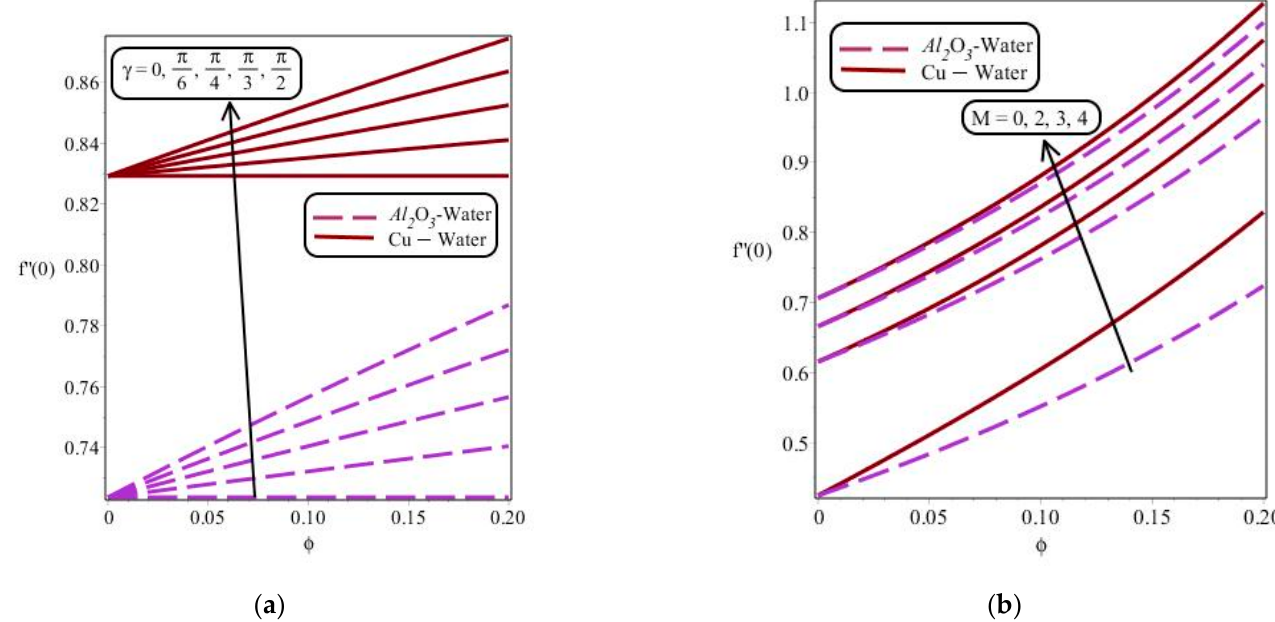
Figure 10. ( a , b ) Impact of M on local skin friction with K 1 = 0.7, β = 0.7, and γ = π /4.